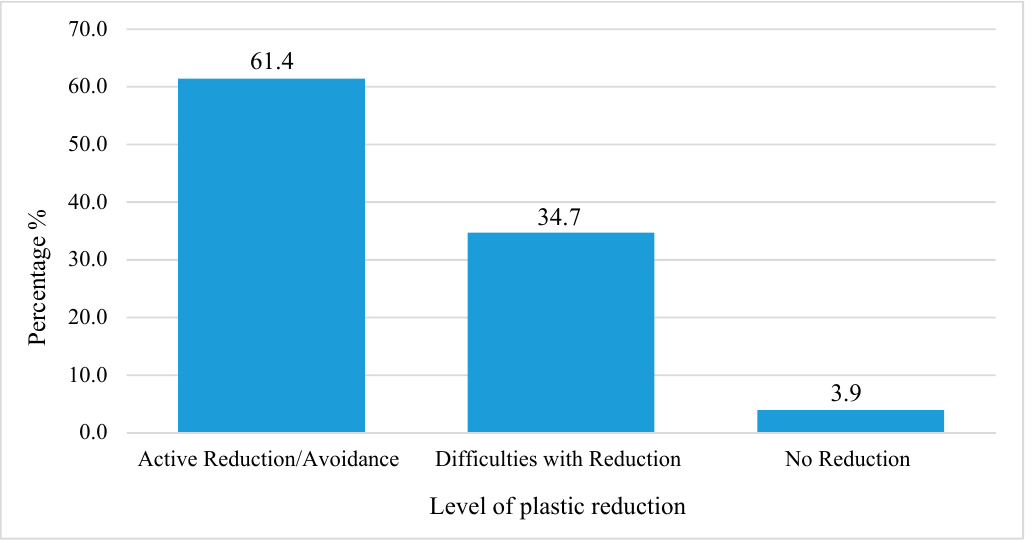
Figure 4. Attitude toward plastic consumption.